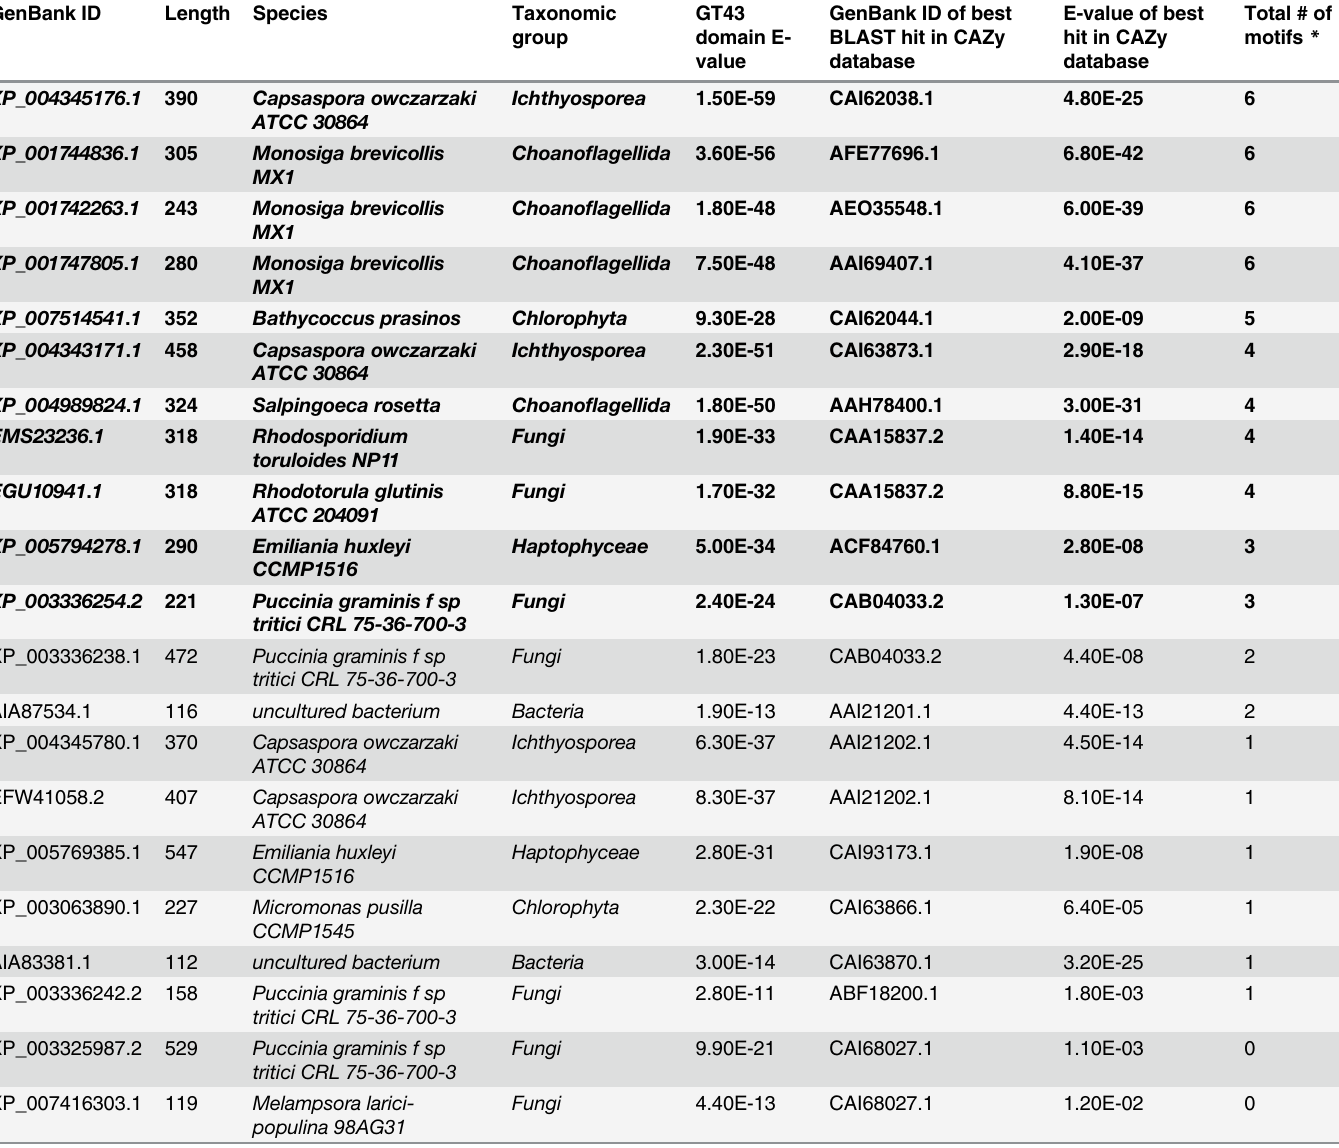
Table 1. 21 NCBI-nr proteins that are non-plant and non-animal proteins and hit the GT43 domain with an E-value < 1e-10; GenBank identifiers (IDs) having at least 3 motifs are shown in bold and italic. GenBank